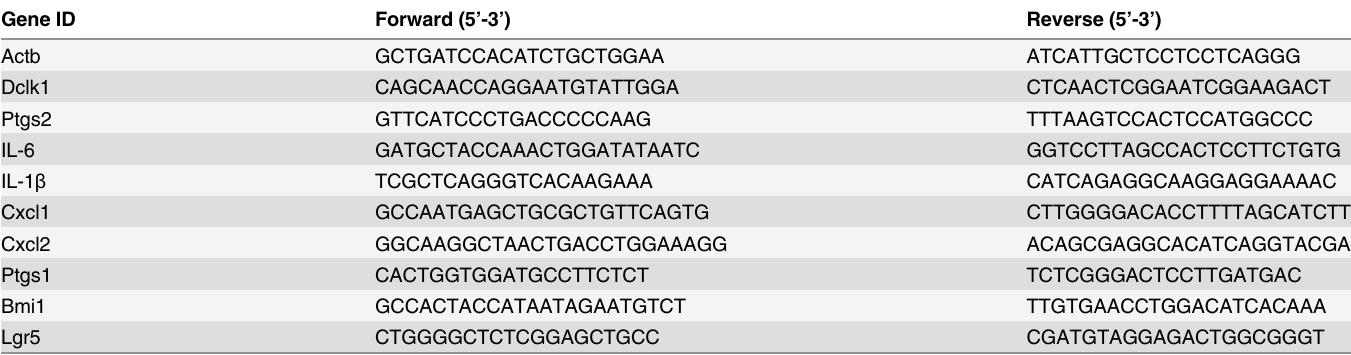
Table 1. Primer sequences for genes analyzed by real-time